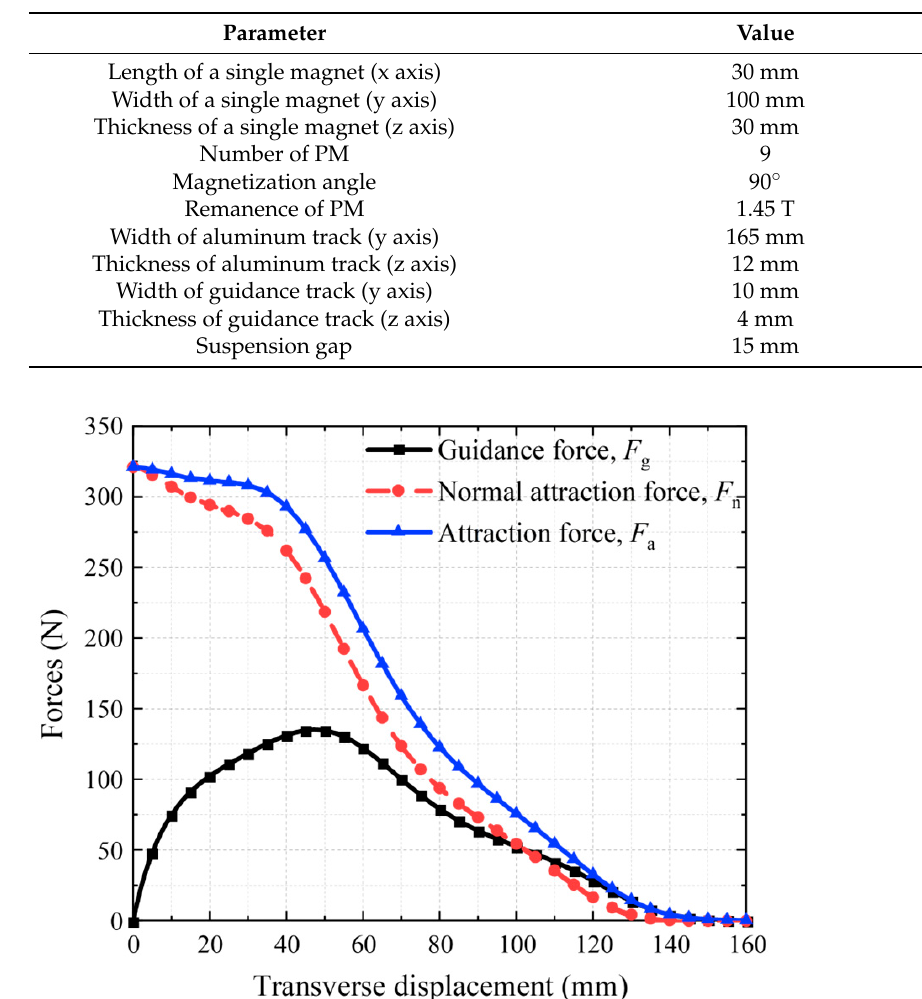
Figure 7. The guidance force and normal attraction force as functions of transverse displacement.